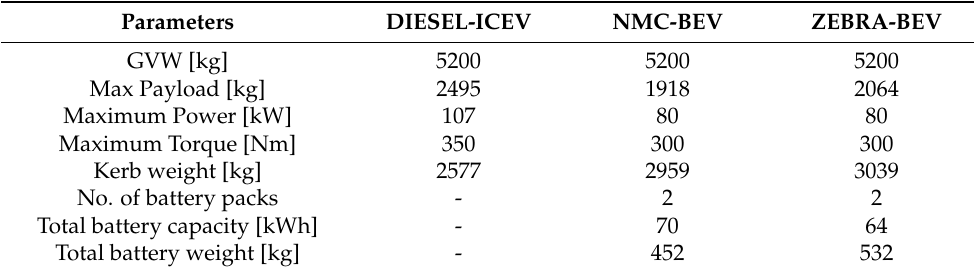
Table 3. Main data of the vehicle.